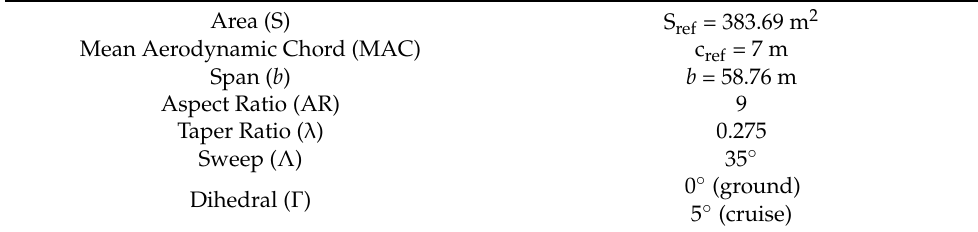
Table 1. CRM aircraft: Main characteristics of the planform [44 − 45]. Area